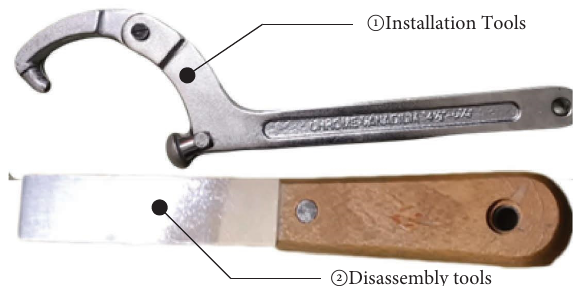
Figure 6: Sketch of installation and disassembly